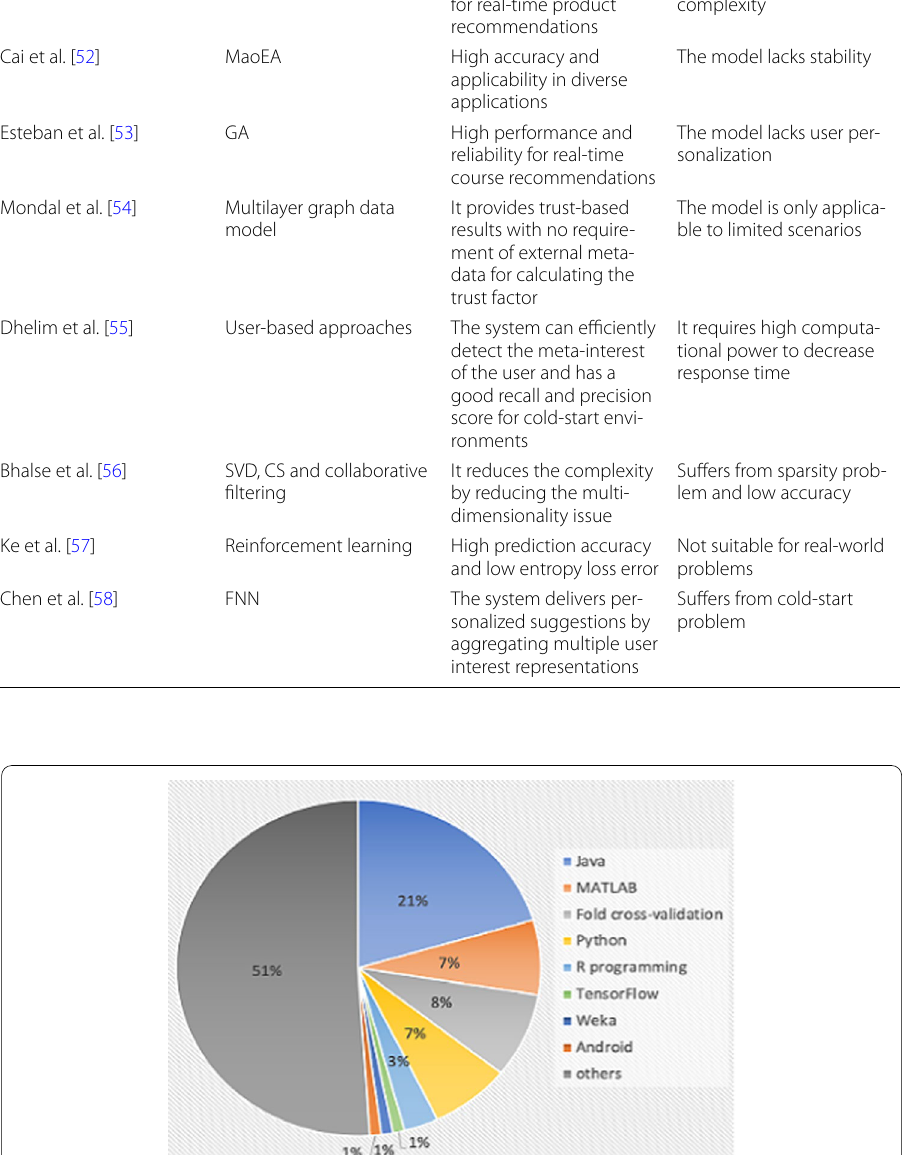
Algorithm (GA) [2, 22, 25, 53] based techniques are used to solve the multi-objective optimization problems of recommender systems. They employ probabilistic transition rules and have a simpler operation that provides better recommender performance.